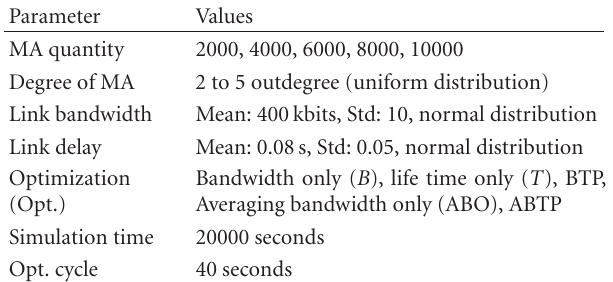
Table 1: Simulation parameters for SIPTVMON.